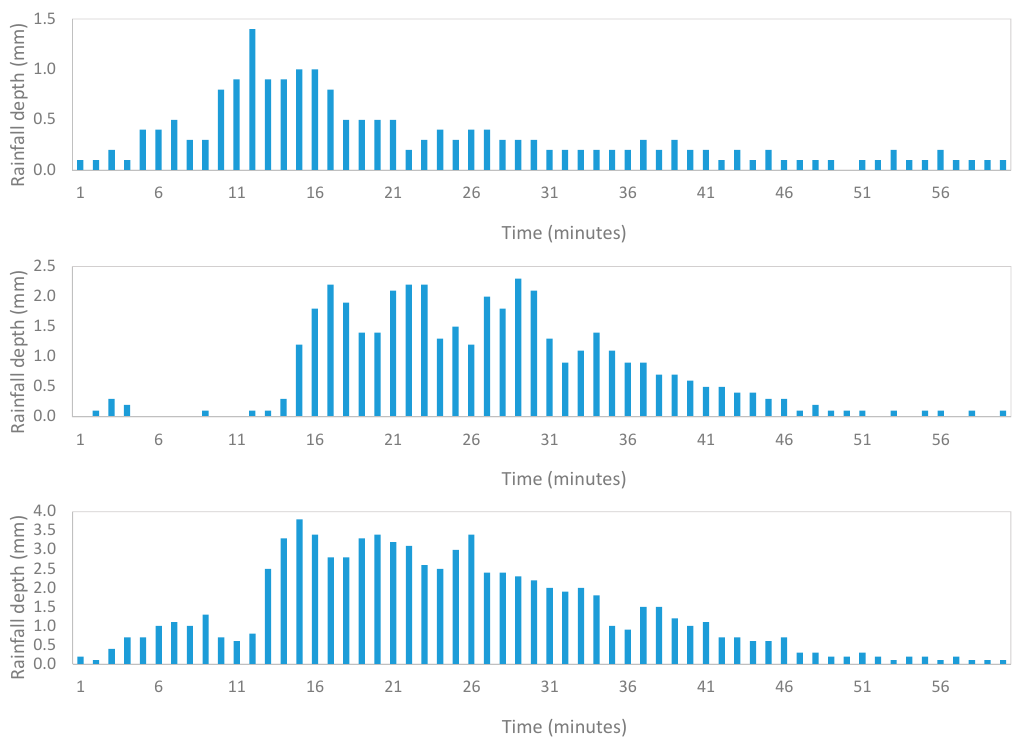
Figure 3. Sample hyetographs recorded at the Bastardo station (Umbria Region, central Italy) involving annual maximum rainfall depths for d = 60 min. From top to bottom, moving windows selected for the years 1993, 1998, and 2011.